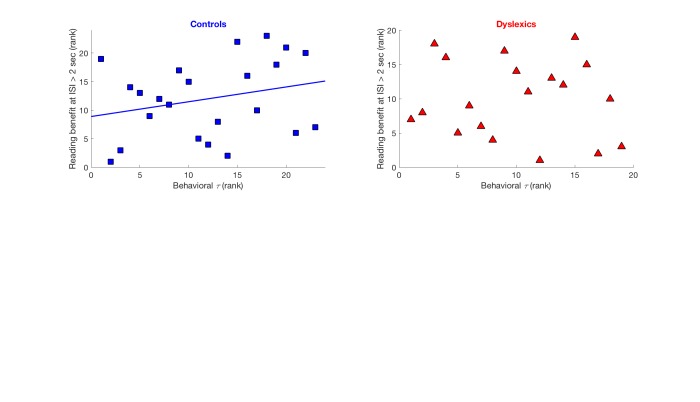
Cross-subject correlation between behavioral time constants of implicit memory decay and behavioral benefits in reading a repeated non-word, when repetition occurred with more than 2 seconds intervals.Left: Significant correlation among controls (Spearman’s R = 0.48, p < 0.05). Right: no correlation among dyslexics (Spearman’s R = -0.28, n.s.). Data shown as rank order to correspond with the statistical test which was applied.